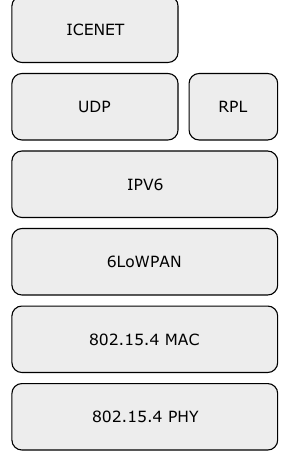
Figure 8. The ICENET protocol